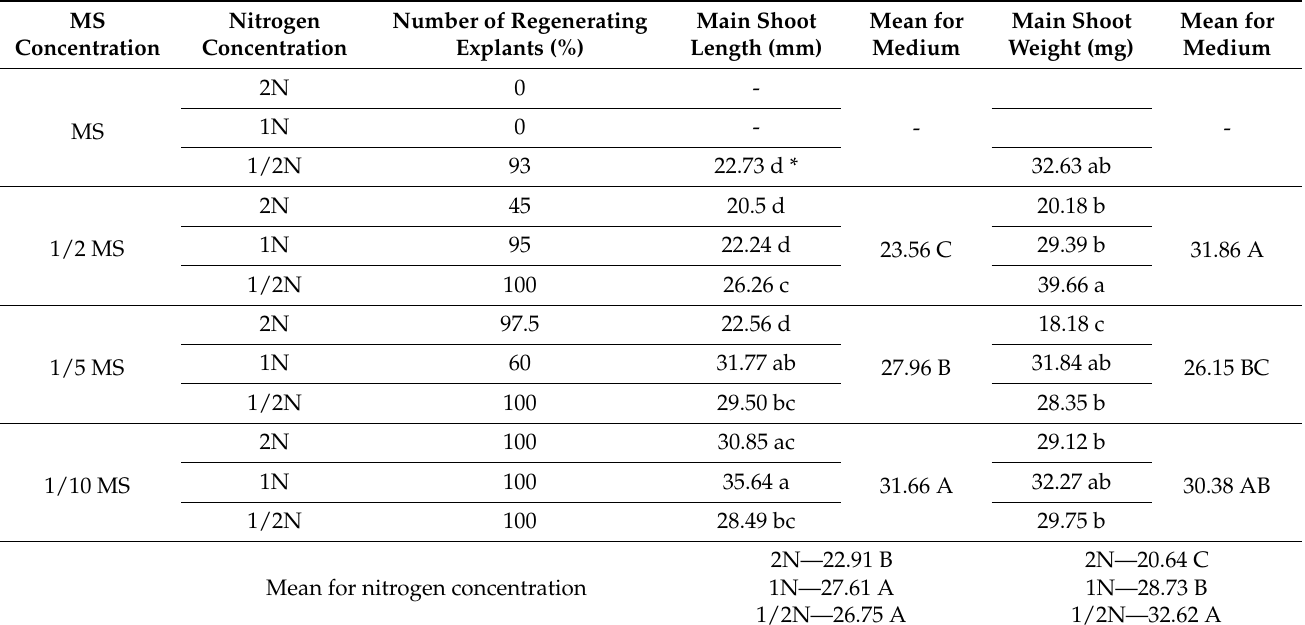
Table 4. Growth and development of Aldrovanda vesiculosa main shoots depending on the concentra- tion of the media and nitrogen compounds.